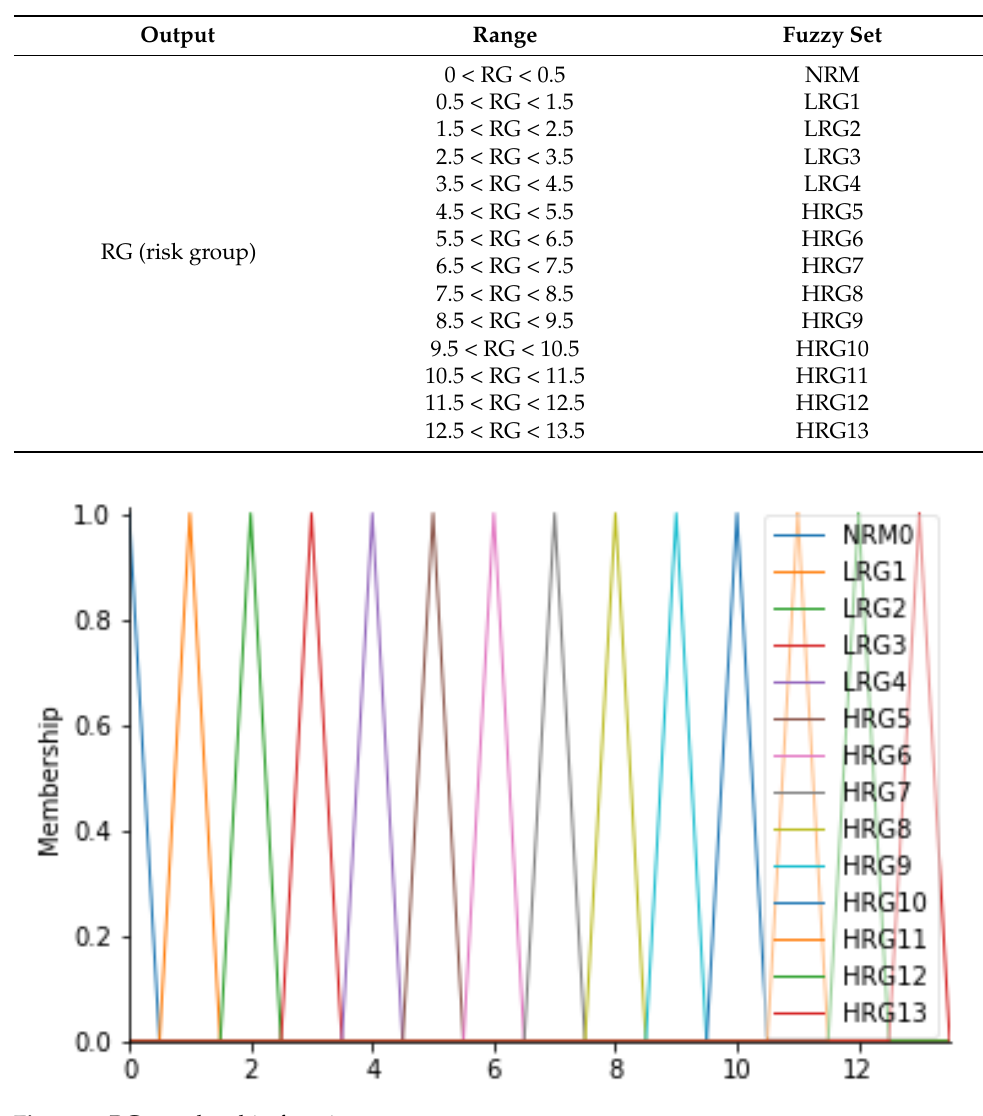
Figure 8. RG membership